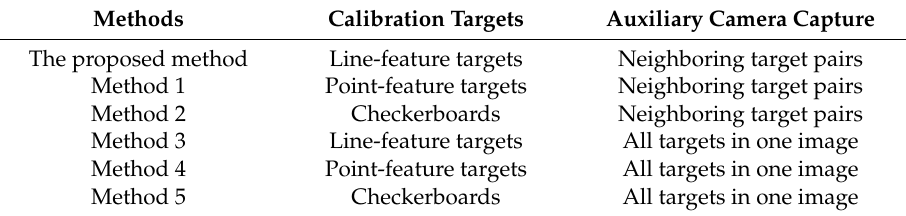
Table 3. Summary of the calibration